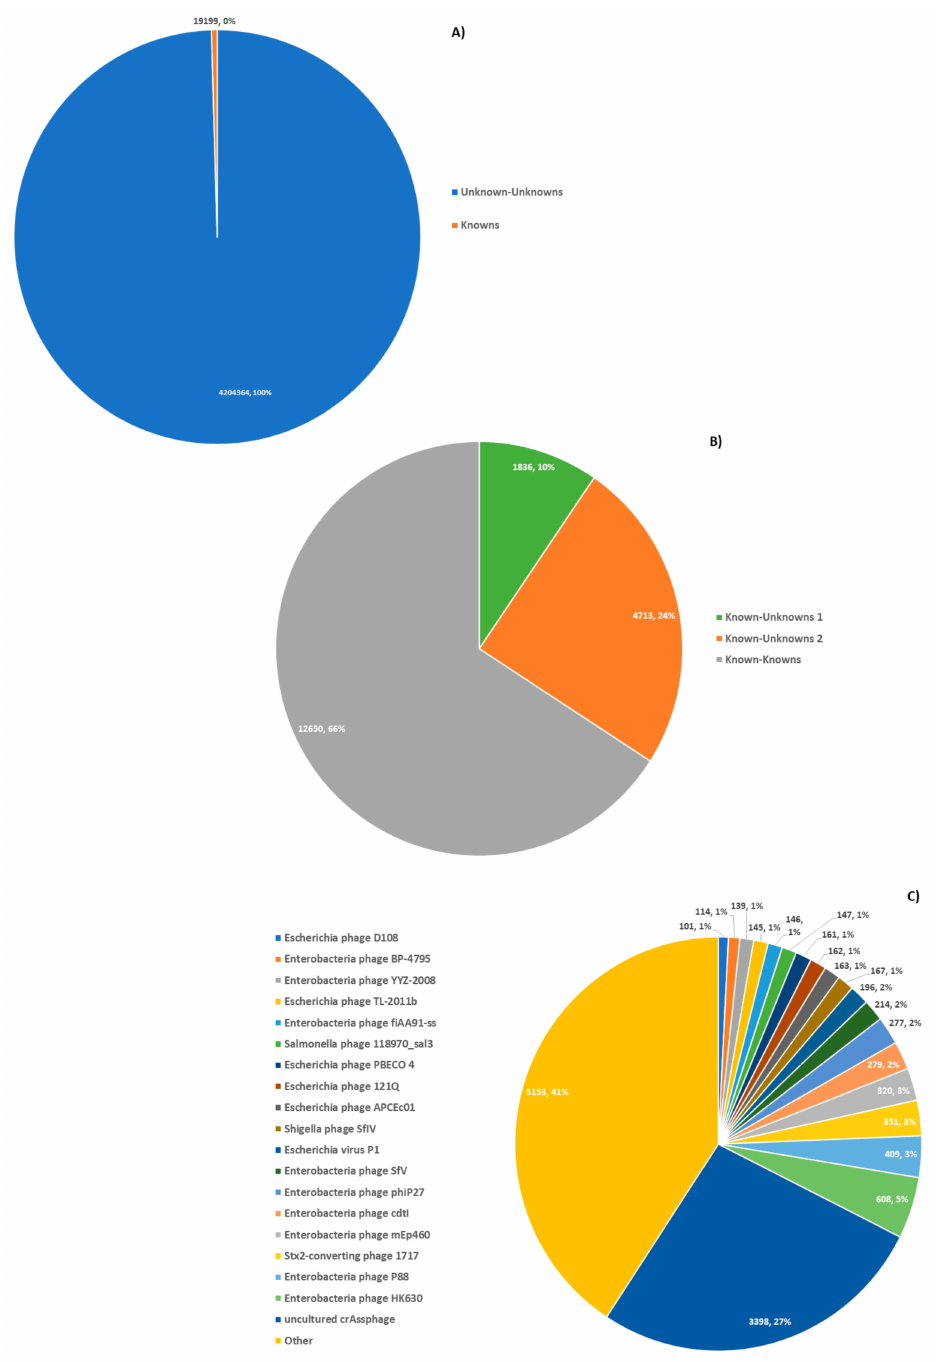
Figure 2. Taxonomic classification of contiguous assemblies. Contiguous assemblies were compared to Virus RefSeq via BLASTN; ( A ) > 99% of contigs have no hits amongst RefSeq viruses. ( B ) Of those with hits against RefSeq viruses, the majority had close matches, known–knowns. The remainder either had a weak match to a RefSeq, ‘known–unknowns’ 1, or a strong match to a RefSeq subsequence, ‘known–unknowns’ 2. ( C ) Top RefSeq viruses matched by ‘known–known’ contigs, by the number of contigs with a match to them. CrAssphage represents the most abundant virus in the